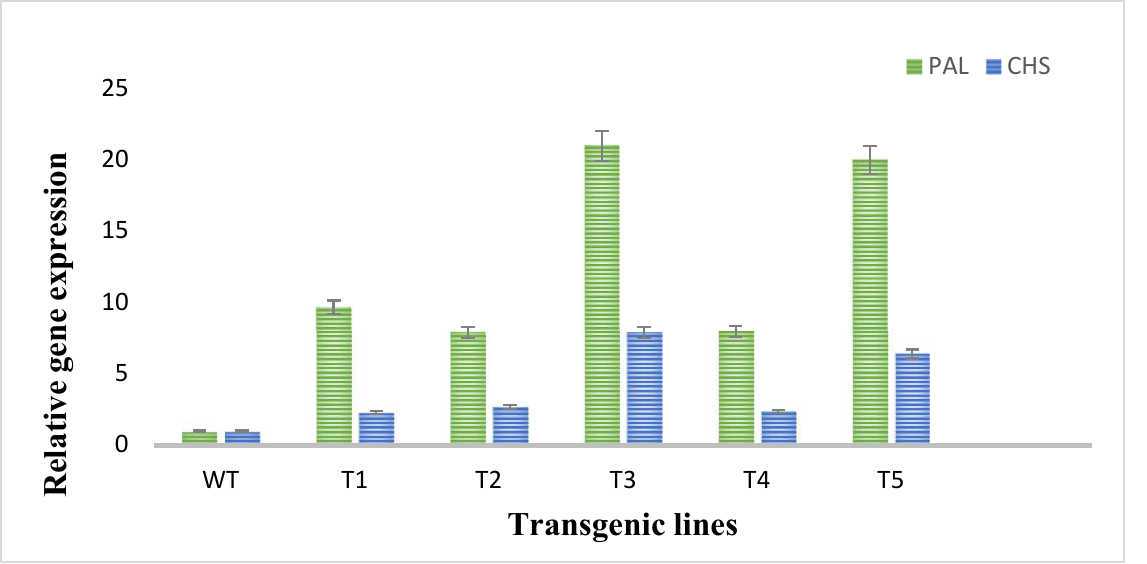
Figure 6. Quantitative real-time PCR analysis of flavonoid biosynthetic pathway genes. PAL and CHS stands for phenylalanine ammonia lyase and chalcone synthase respectively.